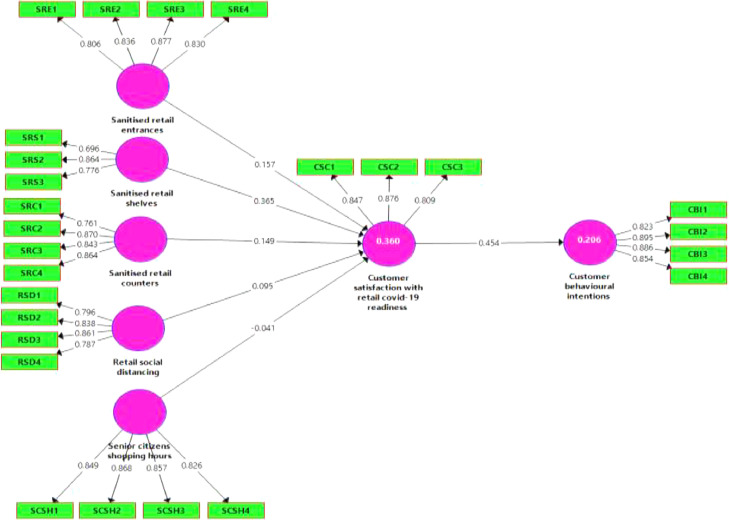
Structural model.